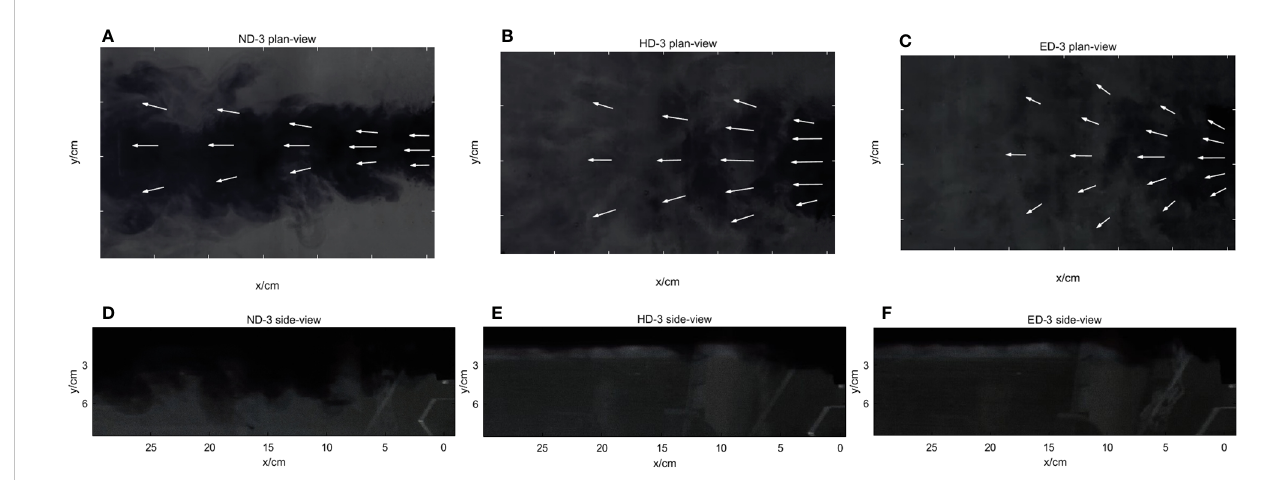
FIGURE 3 Plan and side view of plume with the fl ow rate of 2.5lpm: plan-view of Case ND-3, HD-3 and ED-3 (A – C) ,side-view of Case ND-3, HD-3 and ED-3 (D – F)